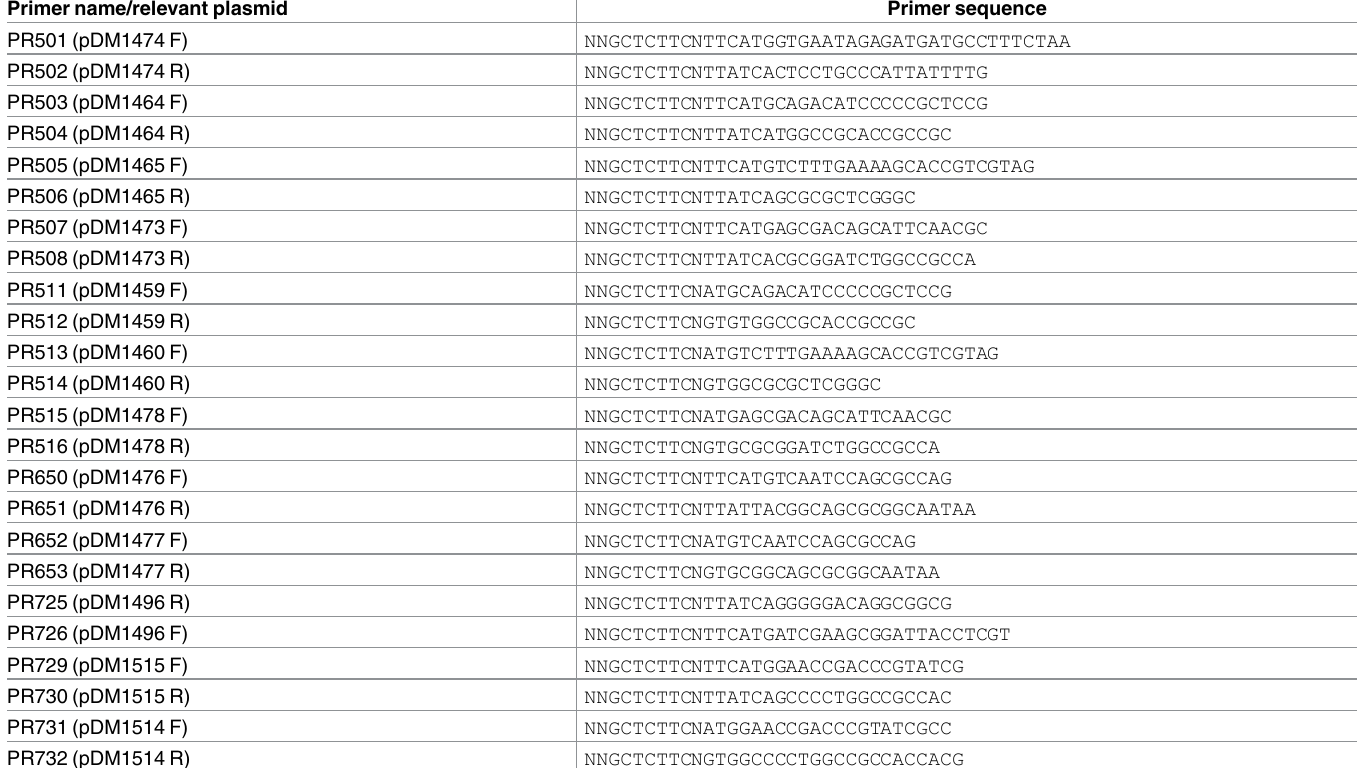
Table 2. Primers used in plasmid